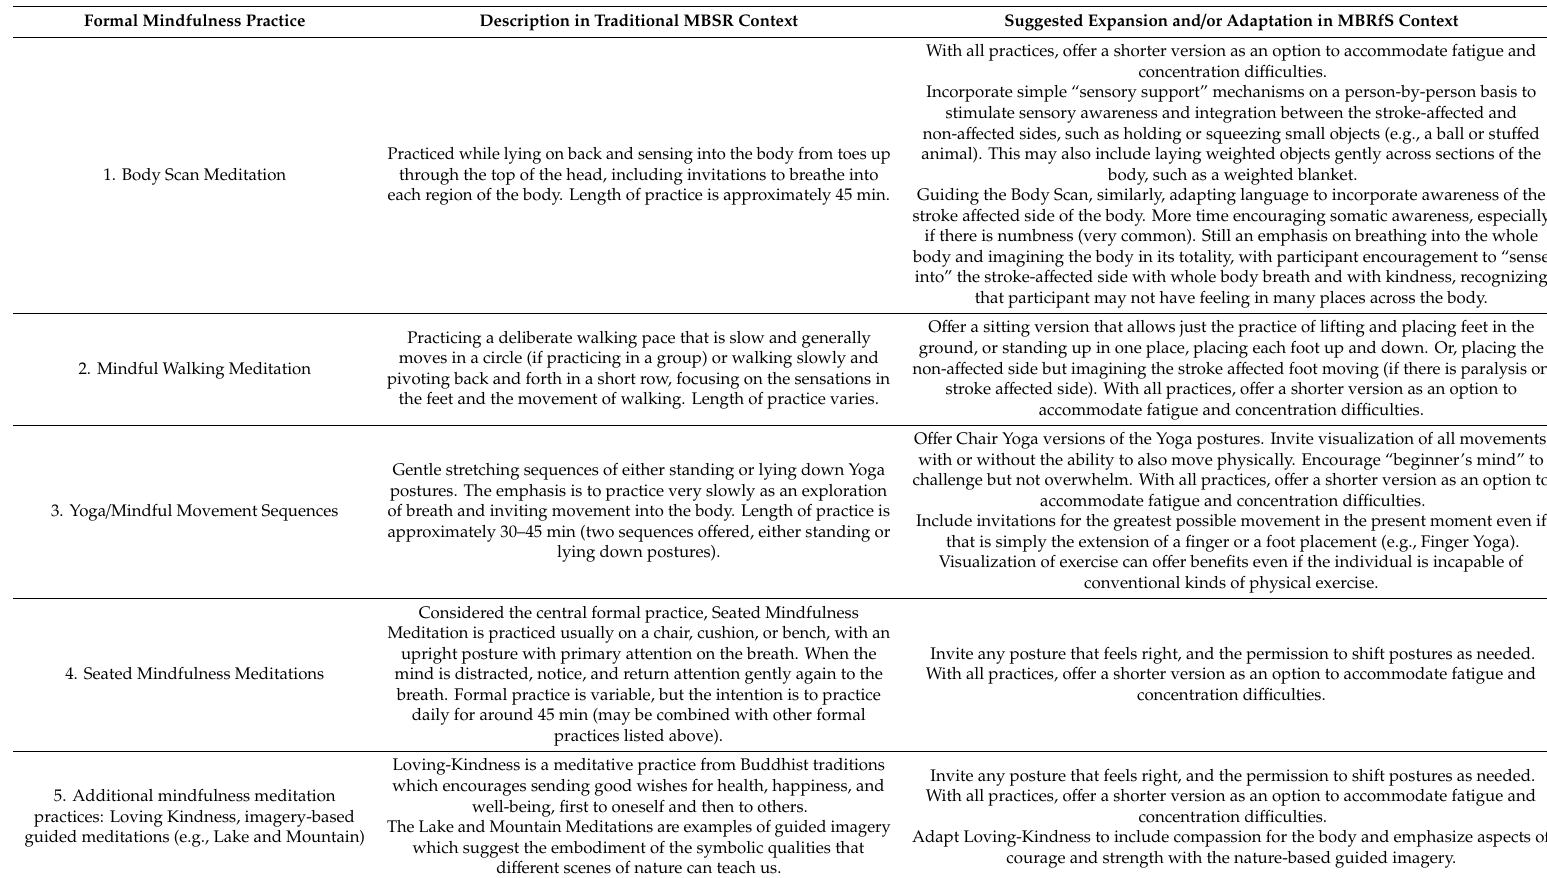
Table 3. Formal mindfulness practices for home practice routine and recommended MBRfS